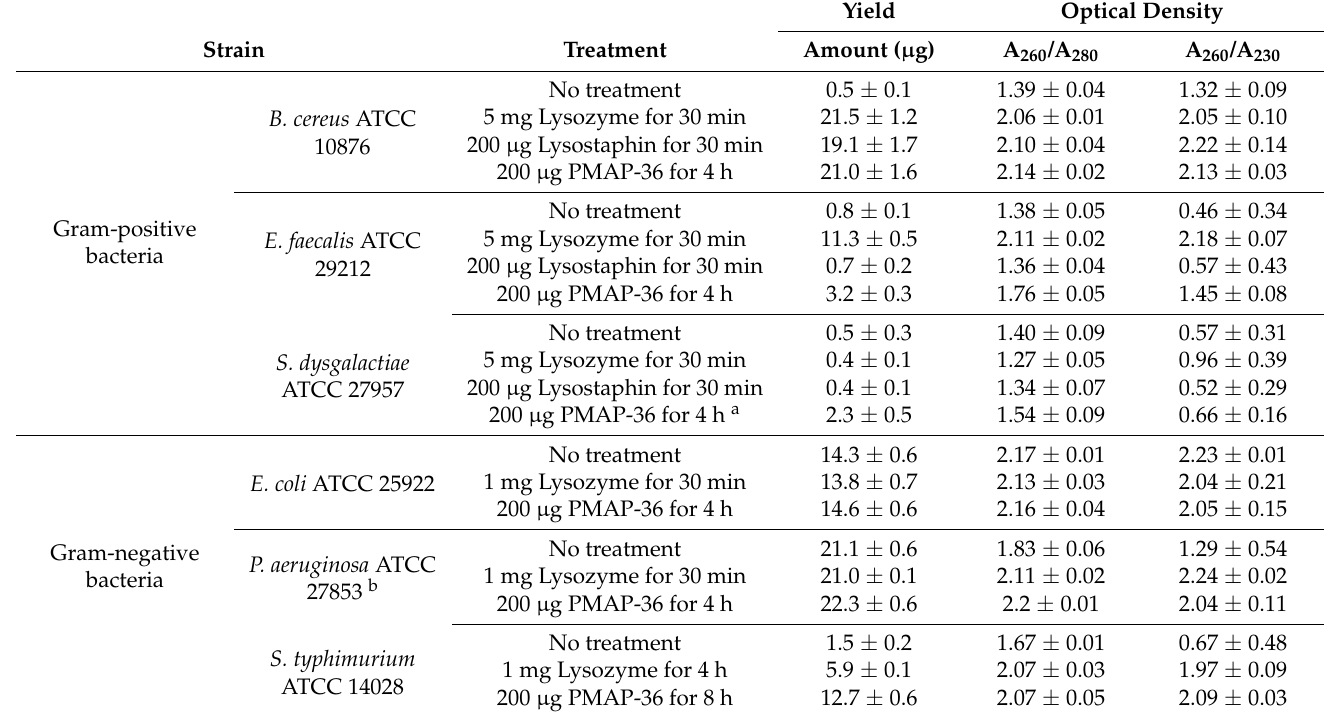
Table 4. Comparison of RNA extraction results using different cell lysis methods for diverse bacterial species. Yield Optical Density Strain Treatment Amount ( µ g) A 260 /A 280 A 260 /A